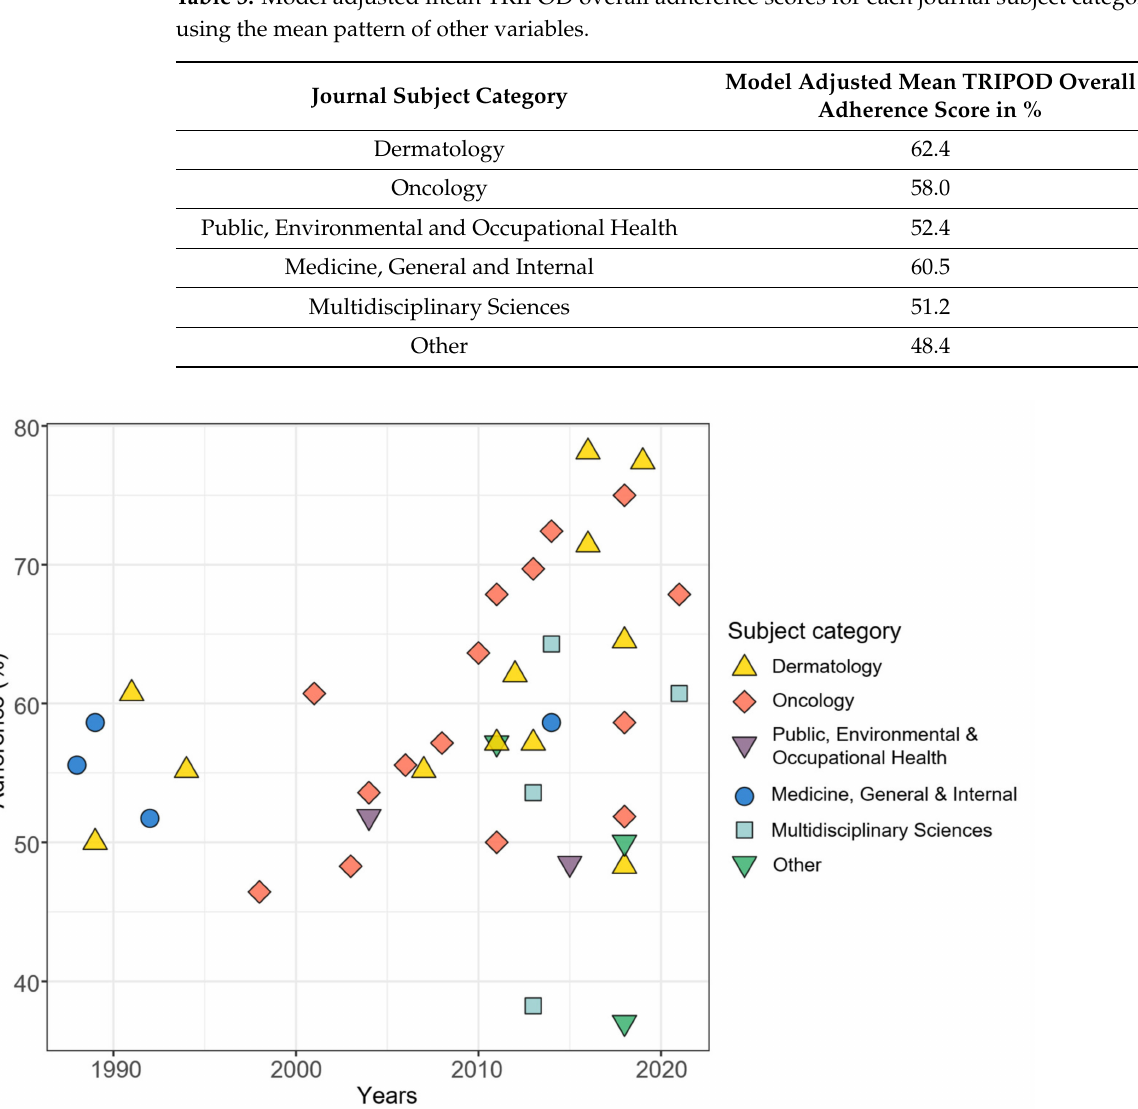
Figure 4. Relationship between TRIPOD adherence and publication year of studies with journal subject categories added. N = 40 (two studies were excluded, see